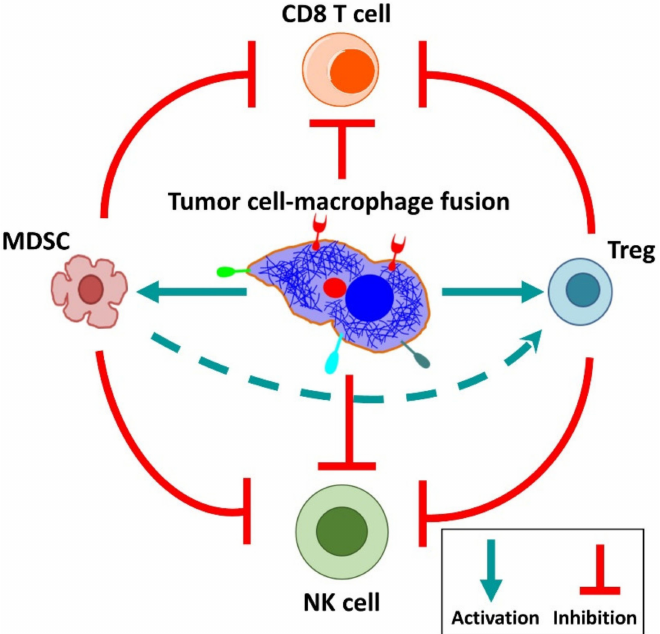
Figure 3. Fusion of tumor cells with macrophages might impact the immune response (Abbreviations: MDSC—myeloid-derived suppressor cell; NK—natural killer cell; Treg—regulatory T